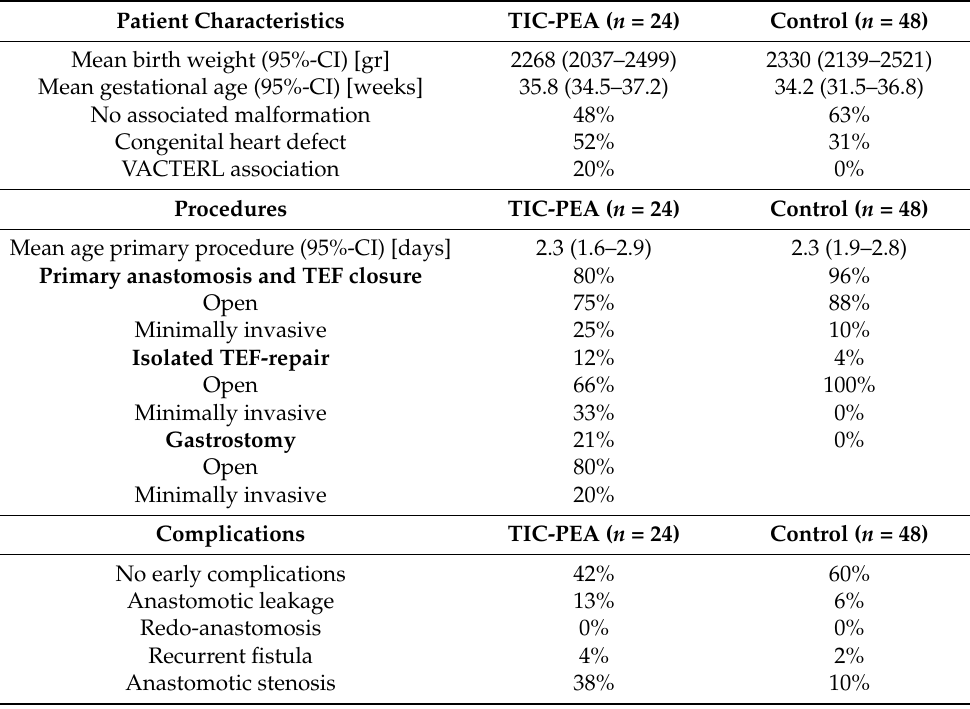
Figure 2. Forest plot of the odds-ratio (OR) on a logarithmic scale of Telemedical Interdisci- plinary Care for Patients with Esophageal Atresia (TIC-PEA) patients with with esophageal atre- sia/tracheoesophageal fistula (Gross Type B/C/D, n = 24) with minimally invasive anastomosis ( a ) or trachea-esophageal-fistula (TEF) repair ( b ) compared to controls ( n = 48) adjusted for birth weight. Table 1. Comparison of patient characteristics, procedures and complications for TIC-PEA patients and controls with EA/TEF (Gross Type B/C/D) included in the